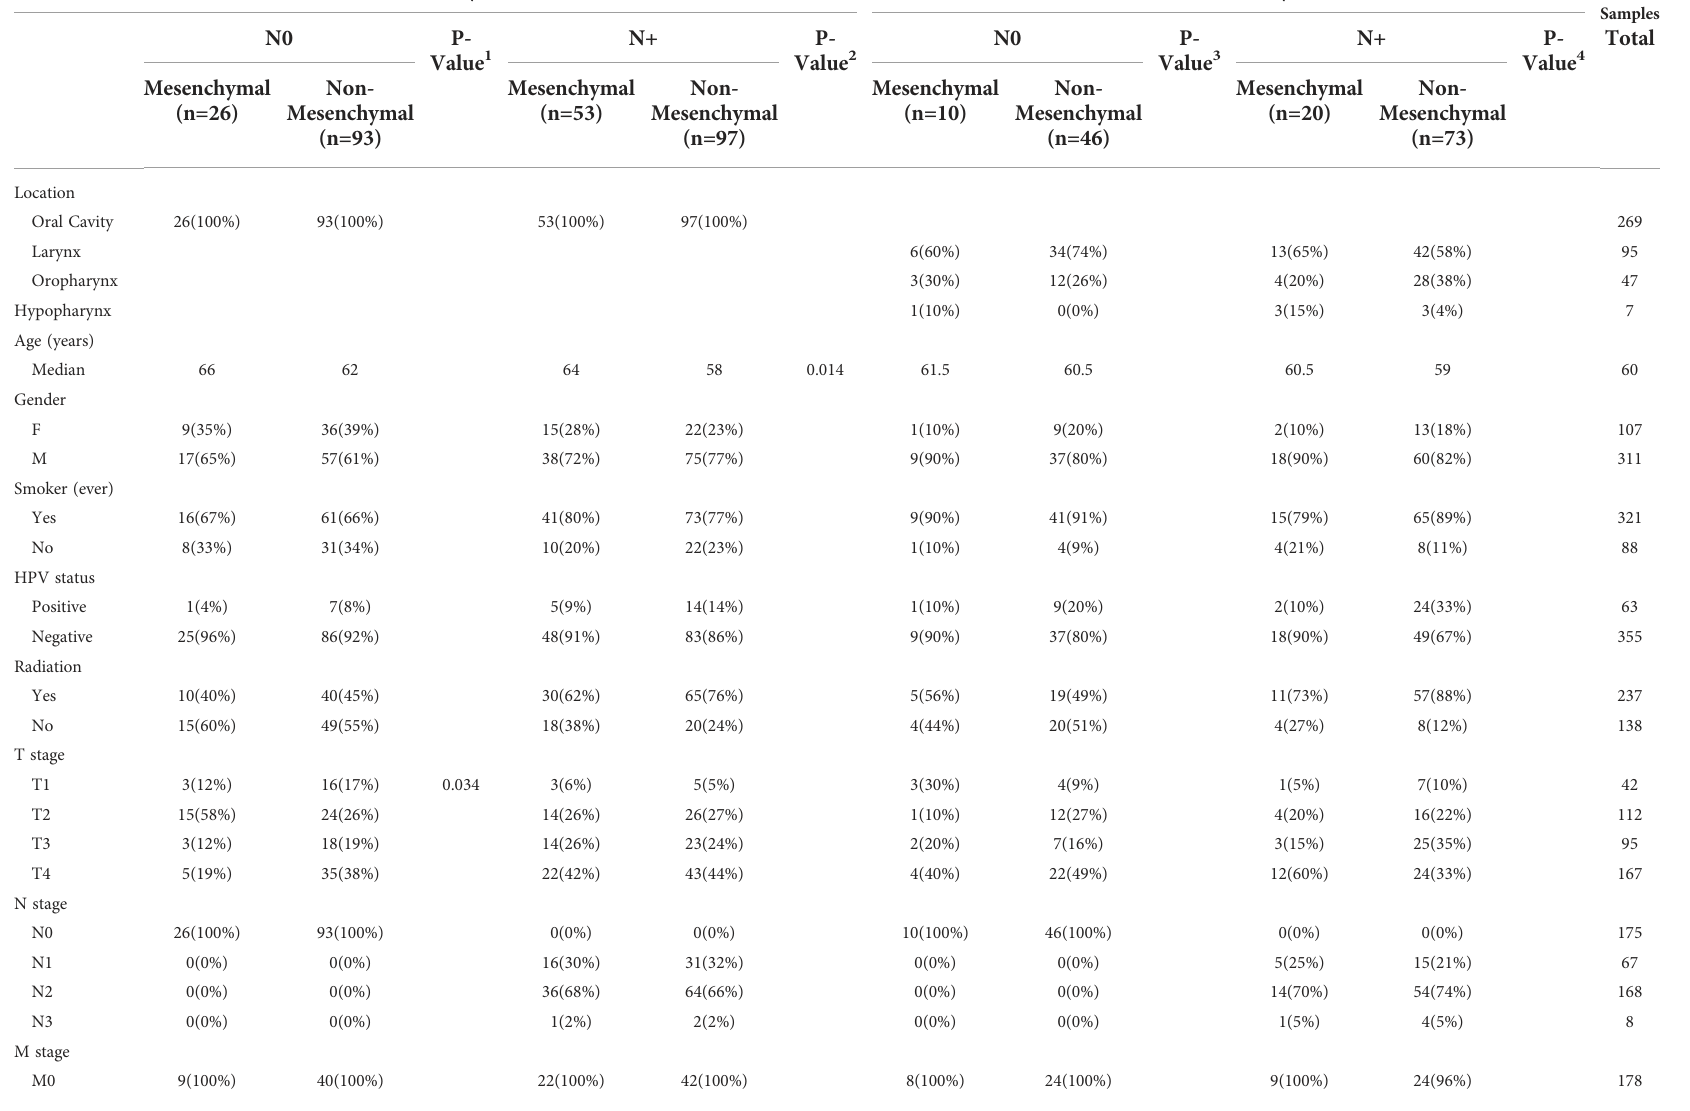
TABLE 1 Descriptive Statistics of Clinical and Demographic Variables by Molecular Subtype